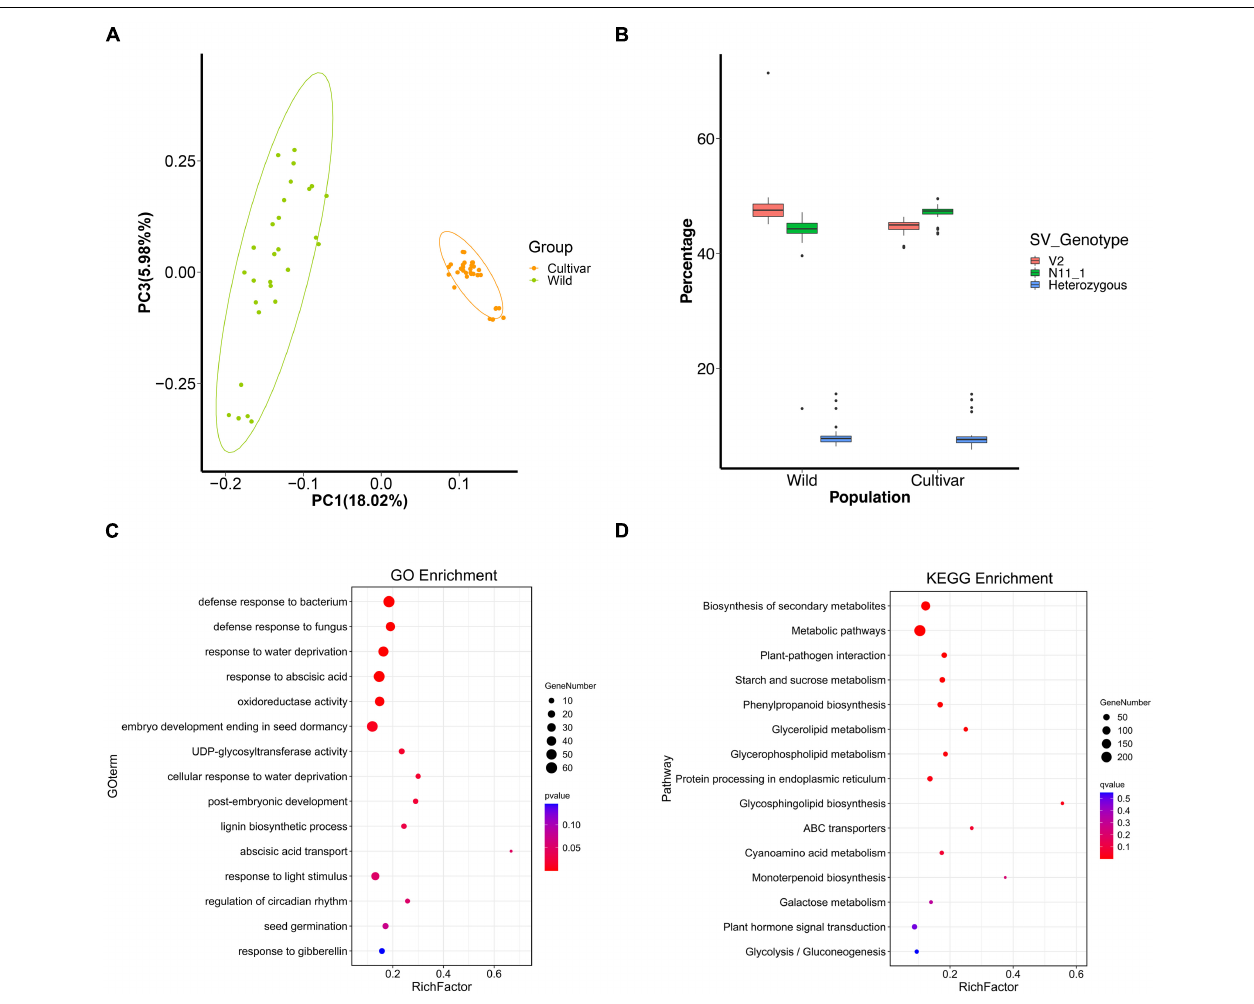
FIGURE 2 | SVs under selection during Chinese chestnut domestication and breeding. (A) PCA plots of wild and cultivated Chinese chestnut accessions. (B) Percentages of SVs with genotypes in different populations. (C) GO enrichment of genes with strongly selected SVs in Chinese chestnut. (D) KEGG enrichment of genes with strongly selected SVs in Chinese